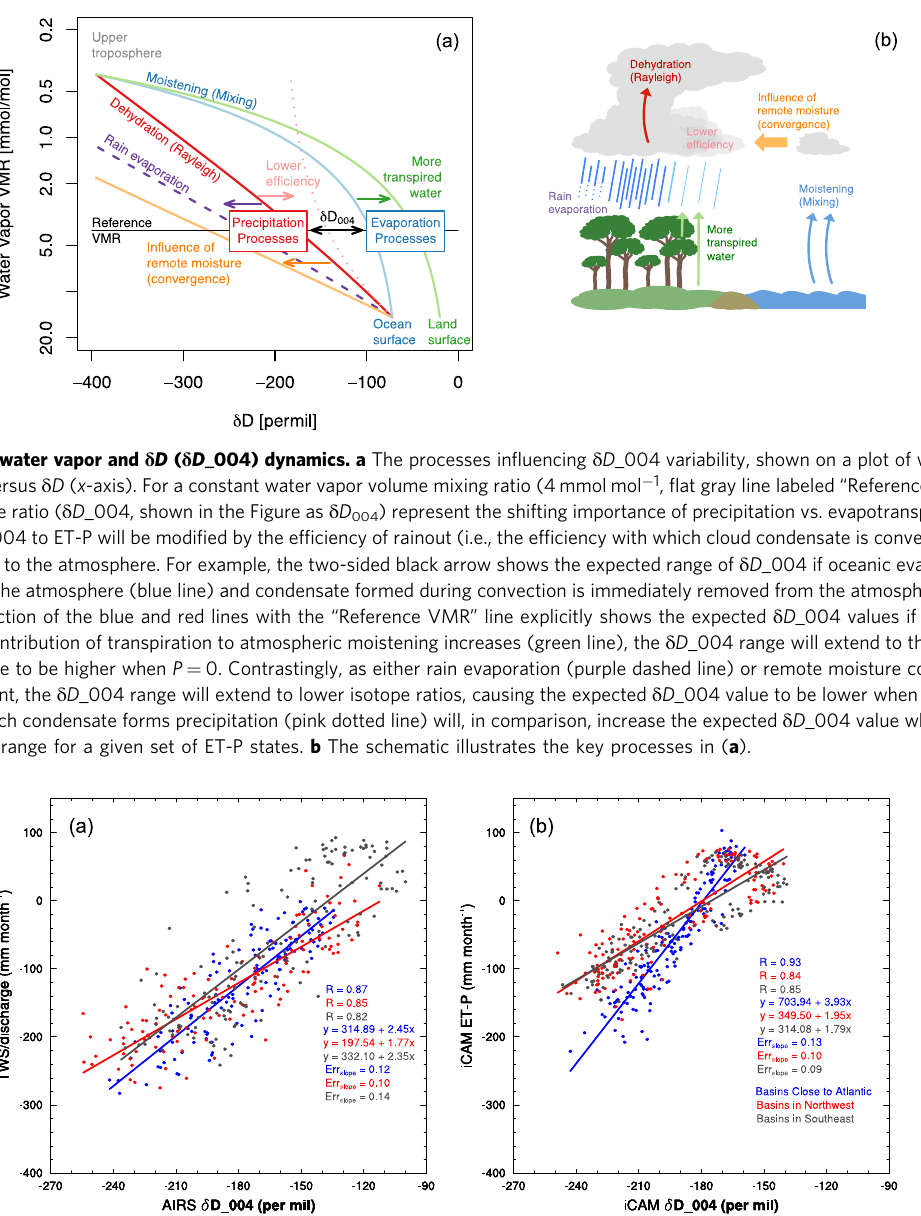
Fig. 2 The regressions of ET-P on δ D_004 from both observations and iCAM. a represents the regressions of TWS/discharge on AIRS δ D_004 and b represents the regressions of ET-P on δ D_004 from iCAM during 2013 – 2015. Here, we use observations and iCAM output at a monthly time scale. Basins close to the Atlantic are river basins 1, 3, 10, and 12 from Fig. 3b; basins in the Northwest are basins 5, 8, 9,13, and 14; basins in the Southeast are basins 2, 4, 6, 7, and 11. For each region, we calculate the area-weighted average of ET-P from TWS/discharge, AIRS δ D _004, and ET-P and δ D_004 from iCAM for all months during 2003 – 2015. Here, the region comprised of basins close to the Atlantic has a higher slope than the other regions, according to both the observations and iCAM, indicating a different moisture